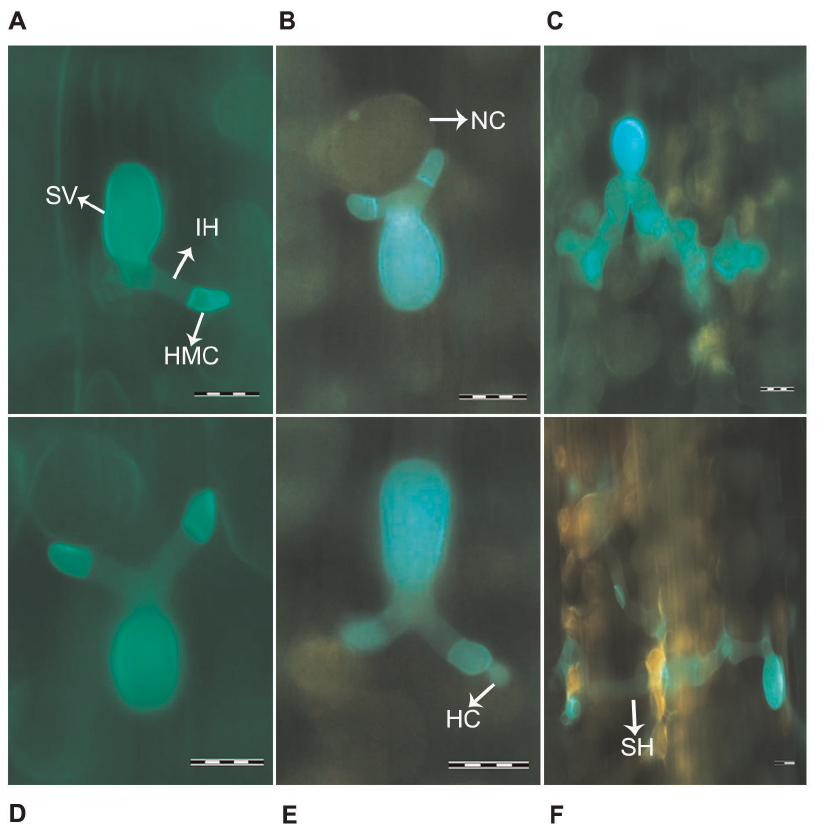
Figure 9. Histological observation of leaves treated with recombinant BSMV viruses and infected with avirulent race CYR23. Typical leaves were examined at 24, 48 and 120 hpi. Treatments a, b, c: BSMV: c infected leaves inoculated with CYR23 examined at 24, 48 and 120 h, respectively. Treatment were d, e, f, BSMV: TaRab7 infected leaves inoculated with CYR23 examined at 24, 48, 120 h. SV, substomatal vesicle; IH, infection hypha; HMC, haustorial mother cell; NC, necrotic cell; SH, second hypha; HC, haustorium cell. Bars=20 m m.